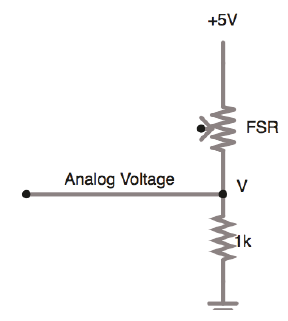
Figure 7: Simplified circuit for